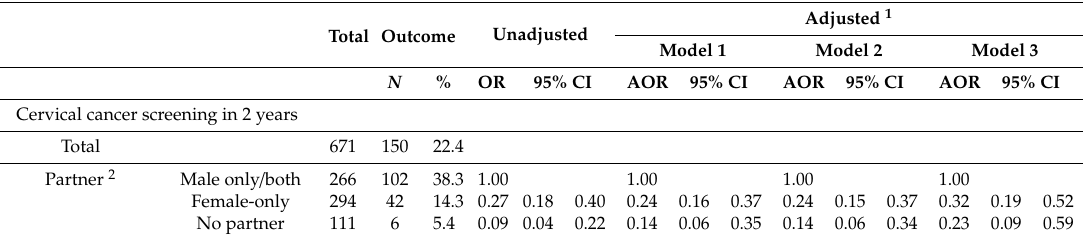
Table 2. Multivariable logistic regression analysis of cervical cancer screening by sex of sexual partners.